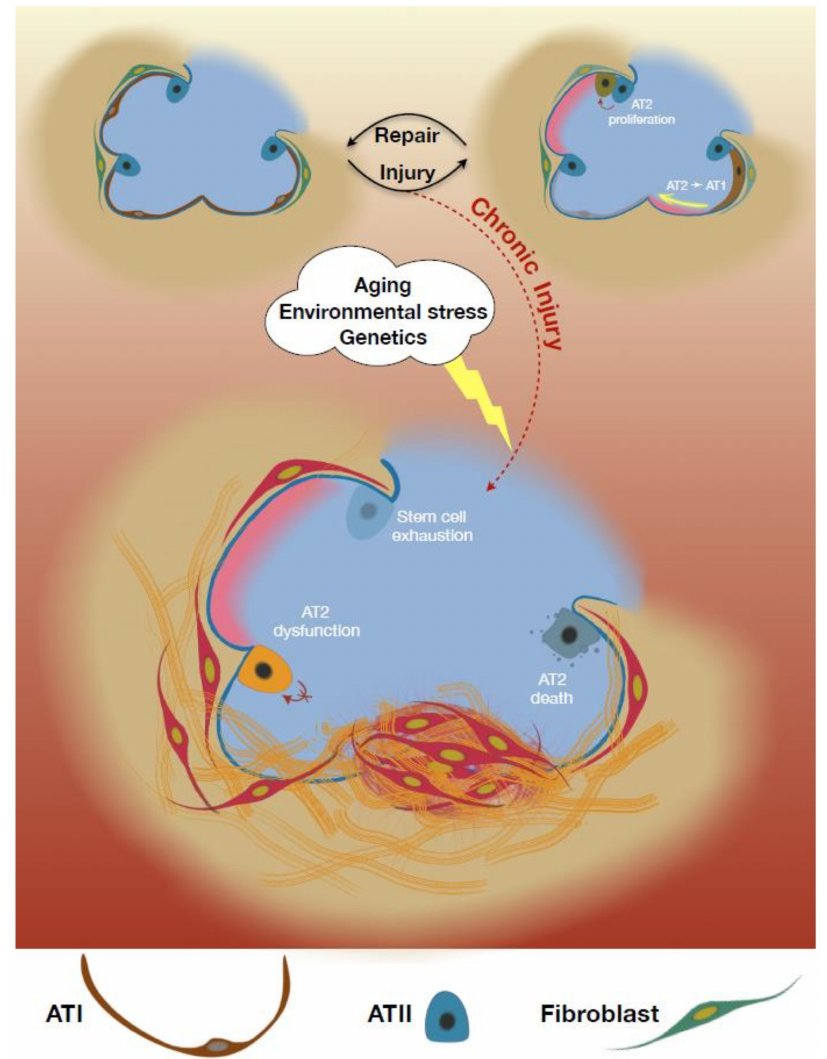
Figure 1. Alveolar epithelial type II cells (AT2) functions in lung fibrosis. An overview schematic illustration described functional roles of AT2 cells to maintain lung homeostasis during injuries and their profibrotic phenotypic changes that promote lung fibrosis upon the presence of risk factors e.g., aging, environmental stress,